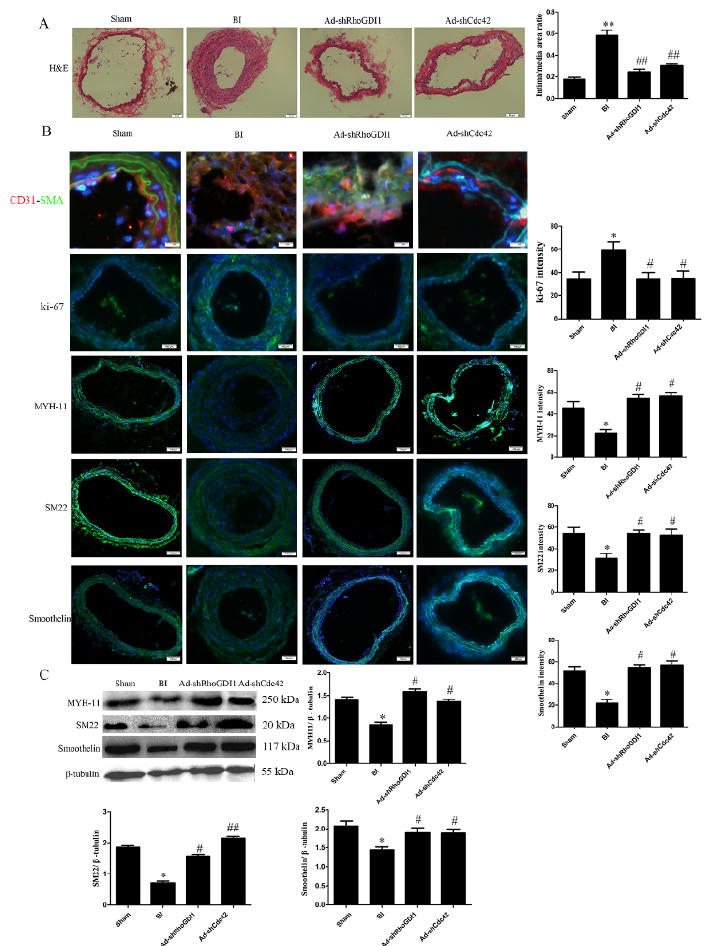
Figure 7. Both RhoGDI1 and Cdc42 suppression inhibit neointima formation and improve the expression of contractile proteins in a rat carotid injury model. For shRNA-mediated knockdown, the carotid artery was injected with approximately 0.2 mL of virus solution (titer: 1 × 10 10 pfu) after balloon injury operation. ( A ) H&E of arteries 14 days after balloon injury. Rats without balloon injury were used as the sham operation group. Histogram showing the area ratio of intima to media. Both RhoGDI1 and Cdc42 knockdown reduced intima/media area ratio. **, p < 0.01 vs. the sham operation group; ##, p < 0.01 vs. the injury model group ( n = 10). ( B ) Immunofluorescence staining for contractile proteins such as MYH-11, SM22, smoothelin (green), ki-67 (green), and α -SMA (green) and CD31 (red) as double staining (merge); nuclei were stained with DAPI (blue). Histo- grams showing the fluorescence intensity of the staining. RhoGDI1 and Cdc42 knockdown reduced the expression of ki-67 and co-localization of α -SMA with CD31 and increased the expression of the three contractile proteins. *, p < 0.05 vs. the sham operation group; #, p < 0.05 vs. the injury model group ( n = 10). ( C ) Western blots showing the expression of MYH-11, SM22, and smoothelin. Histo- grams showing the ratios of the contractile proteins to β -tubulin. The results are consistent with those from immunofluorescence analysis. *, p < 0.05 vs. the sham operation group; #, p < 0.05 and ##, p < 0.01 vs. the injury model group ( n = 10).